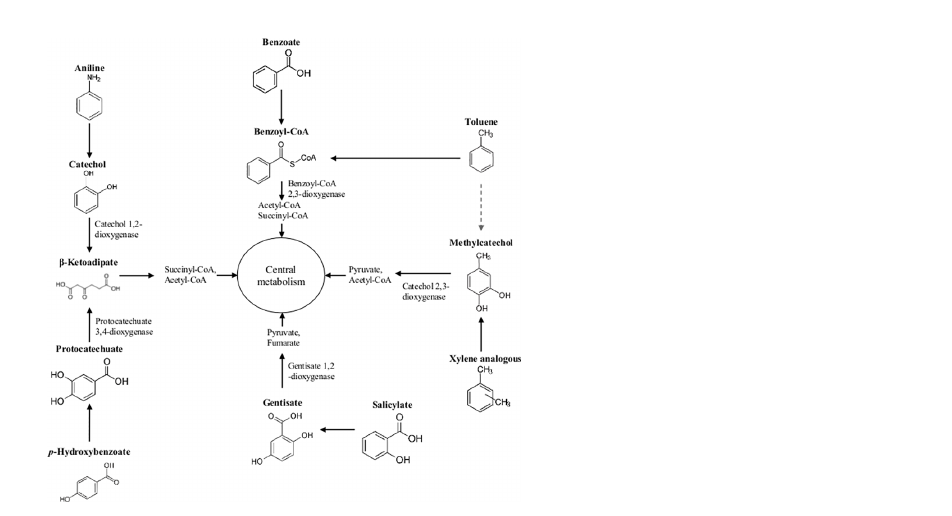
S2 Fig. Phylogenic tree of Burkholderia sp. analyzed with MEGA 6.0.